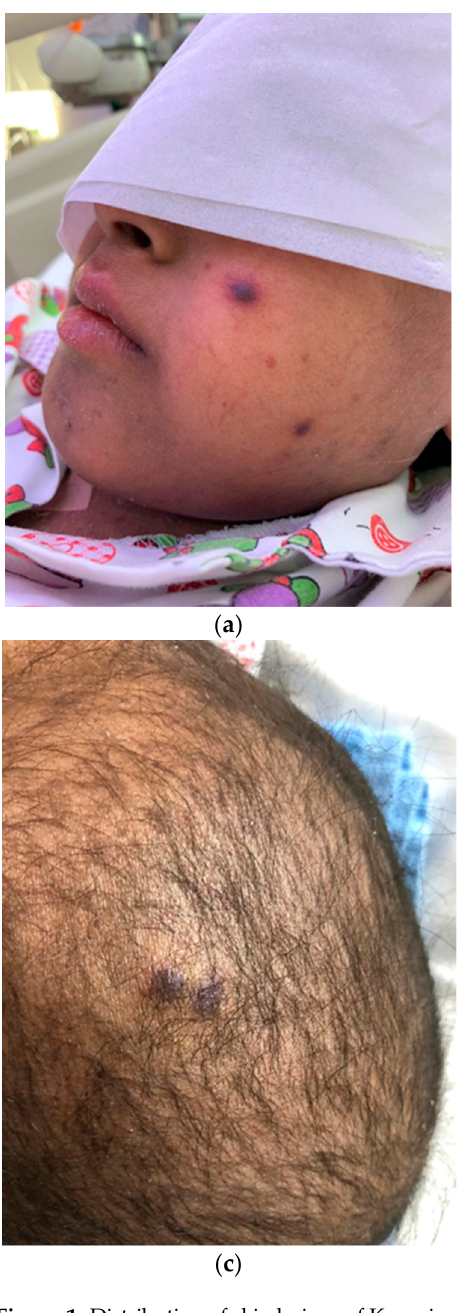
Figure 1. Distribution of skin lesions of Kaposi sarcoma in cheek ( a ), forehead ( b ), scalp ( c ), and chest ( d ).